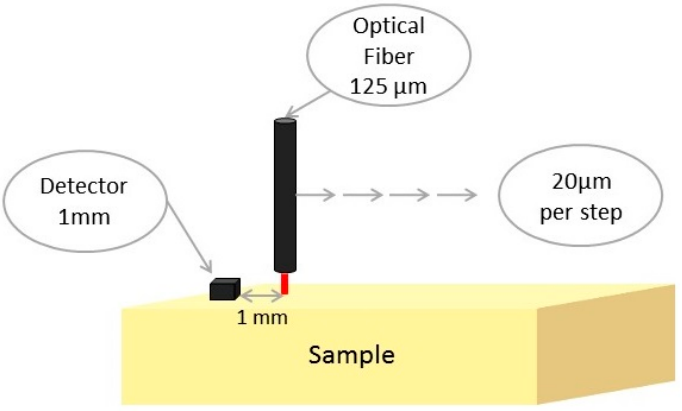
Figure 11. A schematic representation of the DR system.